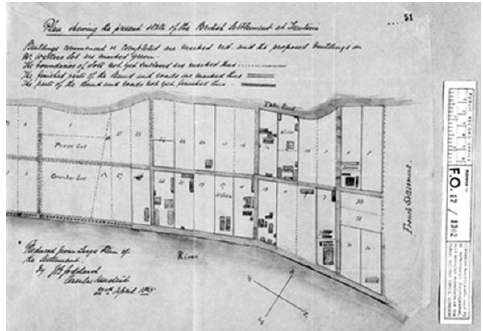
Figure 2 . Map of the land parcels in the British Concession of Tianjin in 1865 (Source: British National Archives FO17/1302